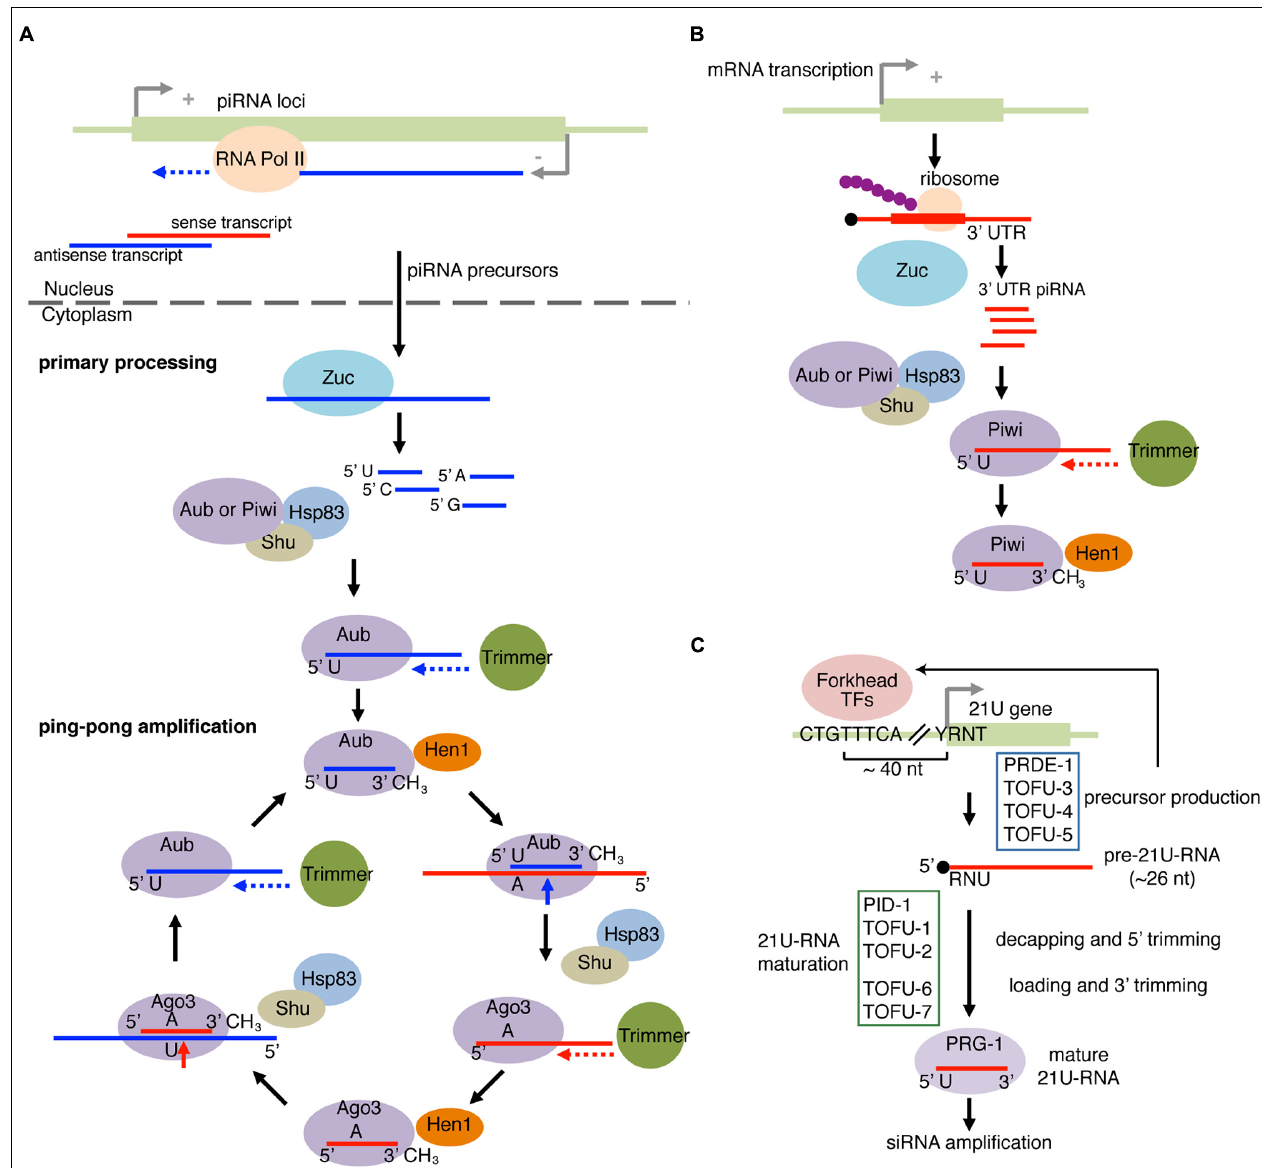
FIGURE 4 | piRNA pathway and 21U-RNA pathway. (A) Primary piRNA processing and ping-pong amplification cycle in fly. piRNA precursor transcripts are produced from piRNA loci and are cleaved by an endonuclease Zucchini (Zuc).The PIWI proteins Aubergine (Aub) or PIWI with co-chaperones select the piRNA precursor fragments with enrichment for those with 5 (cid:3) U. The loaded piRNA precursor fragment in PIWI or Aub is then trimmed on the 3 (cid:3) end by a hypothetical exonucleaseTrimmer, and 2 (cid:3) - O -methylated at the 2 (cid:3) position of the 3 (cid:3) nucleotide by the Hen1 methyltransferase. In the ping-pong amplification pathway, Aub with the mature piRNA targets transcripts bearing the complementary site.The 5 (cid:3) U on the mature piRNA would base pair with an A located on the complementary site. Cleavage occurs 10 nucleotides (inclusive of A) upstream of A, forming the new 5 (cid:3) end. Shu and HSP83 facilitate the removal of the cleaved 5 (cid:3) upstream fragment.The cleaved 3 (cid:3) fragment is then passed to AGO3 and trimmed byTrimmer followed by Hen1 methylation at the 3 (cid:3) end to form the secondary piRNA/AGO3 complex.This complex recognizes the complementary transcripts from the piRNA clusters and continues the cycle to amplify piRNAs. (B) piRNAs from mRNA 3 (cid:3) UTR.